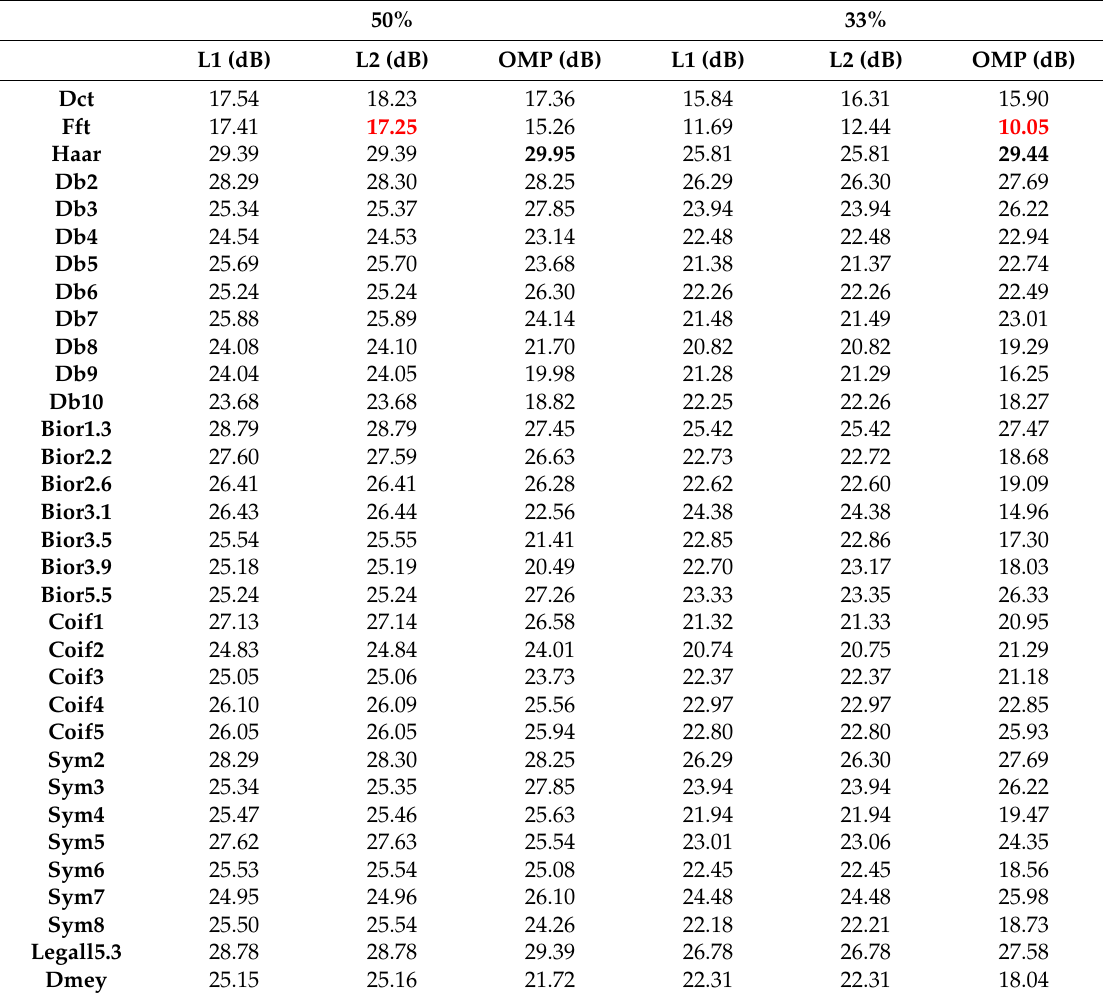
Table 3. PSNR calculated with different bases and recovery methods for experimental data acquired at a copper mine in South